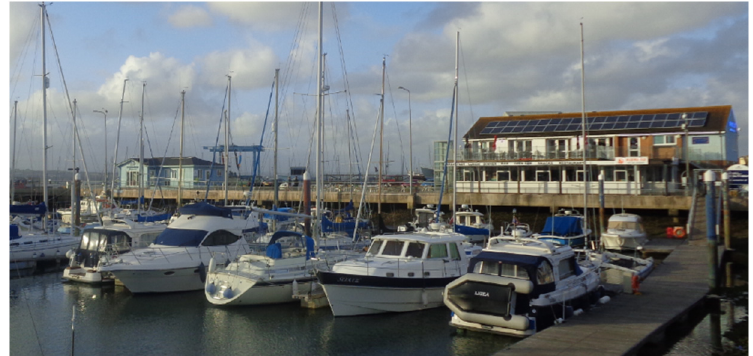
Figure 4. The identification of a marina unit’s environment, Kinsale, IE. Figure 5. Viewpoints of the watershed depending on the distribution of the pontoons and boats, La Herradura (Granada) and Ceuta, ES.